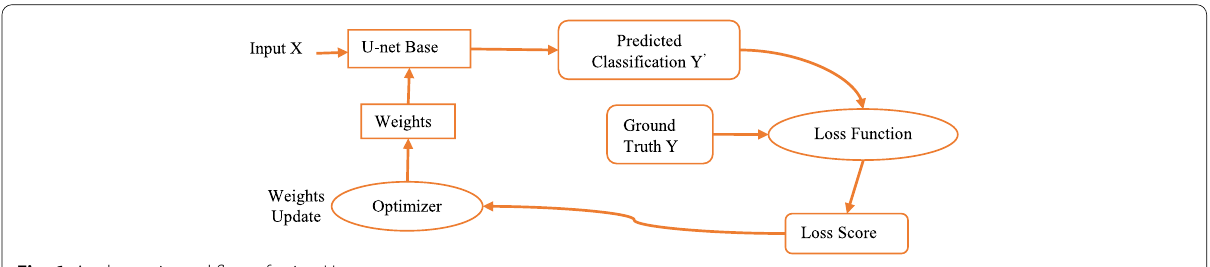
Fig. 6 A schematic workflow of using